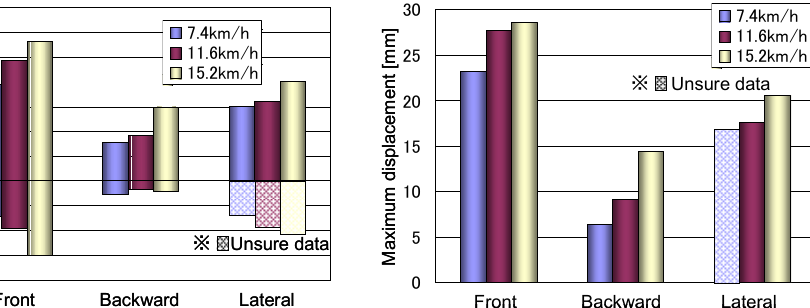
Fig. 9 Comparison of positive or negative maximum velocity for impacts at 7.4, 11.6, and 15.2 [km/h] for each impact direction.